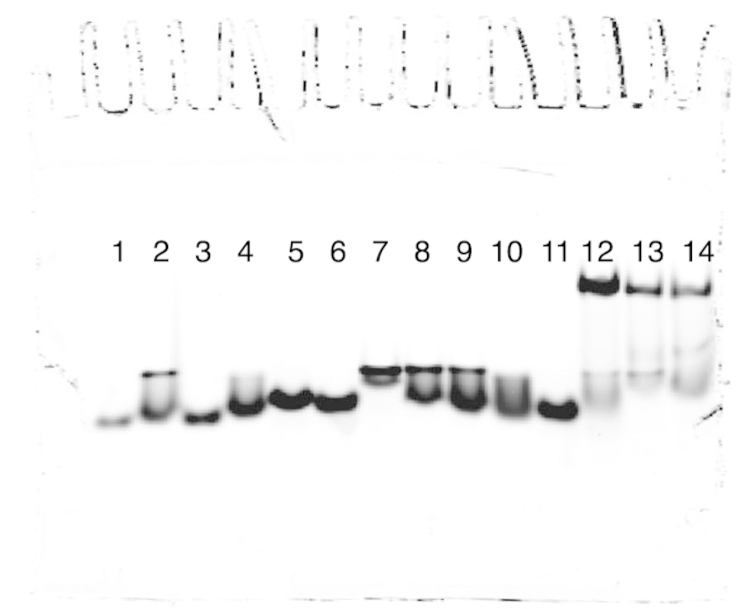
Comparison of multi-DNAs vs. J1, 4WJ:PNA1 and b4WJ:PNA1.